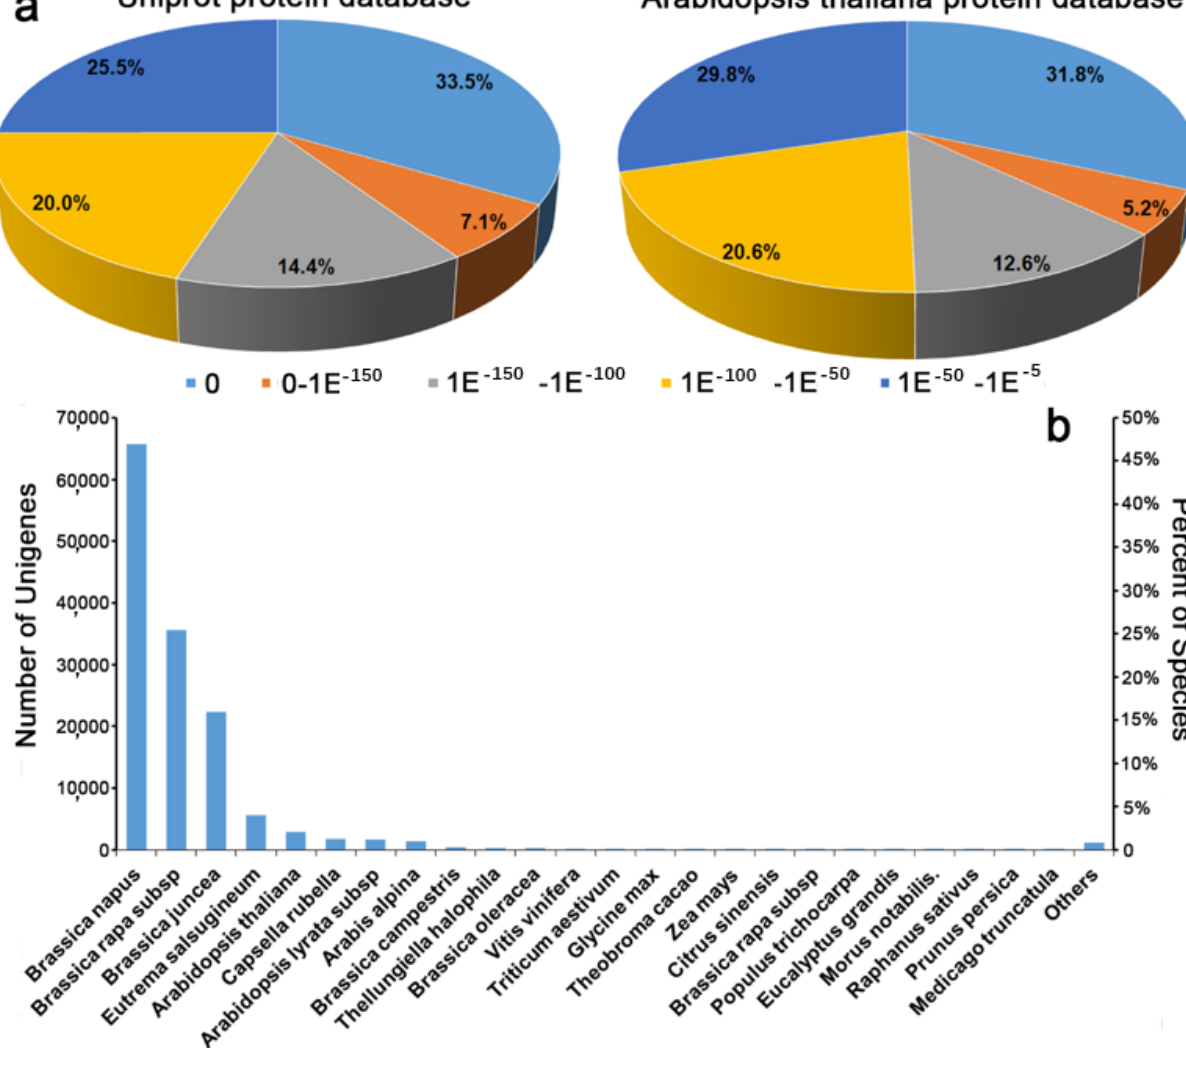
Figure 1. Blast E -value and distribution of top-hit species for transcriptome sequence: ( a ) Blast E -value on Uniprot protein database and Arabidopsis thaliana protein database; ( b ) the 25 top-hit species based on Uniprot annotation.